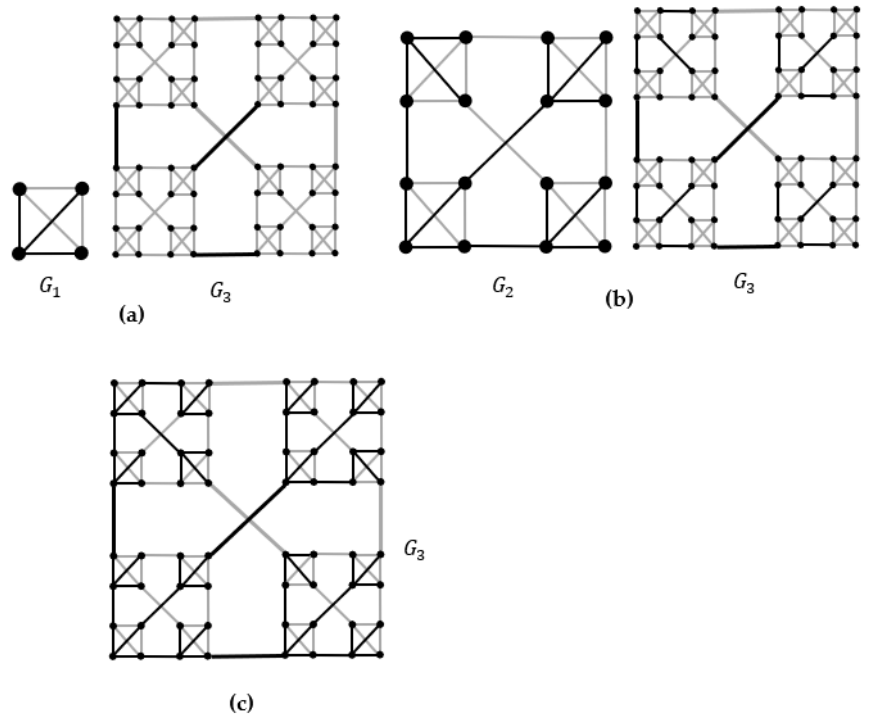
Figure 5. The of spanning trees for G 1 , G 2 and G 3 . Consequence 4. Algorithm 2 selects a minimum weight spanning tree of a prefractal graph weighted by a similarity coefficient θ < a / b